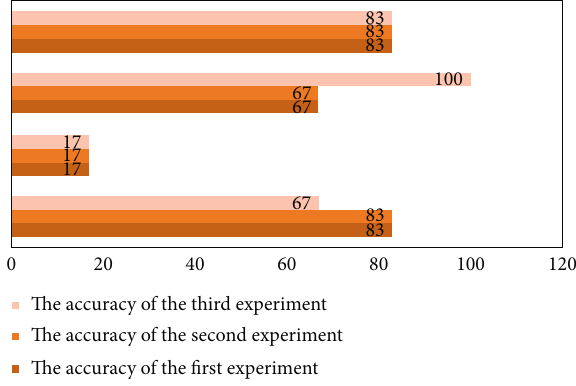
Figure 5: Accuracy (%) of the test set identi fi cation process using nonstationary K -means.